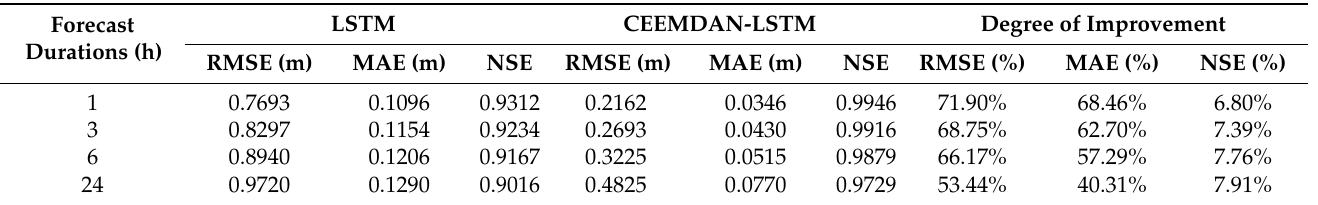
Table 2. Comparison of ShiDao measured and predicted values by error evaluation indicators between CEEMDAN-LSTM and LSTM with degree of improvement for the 1-, 3-, 6- and 24-h forecast